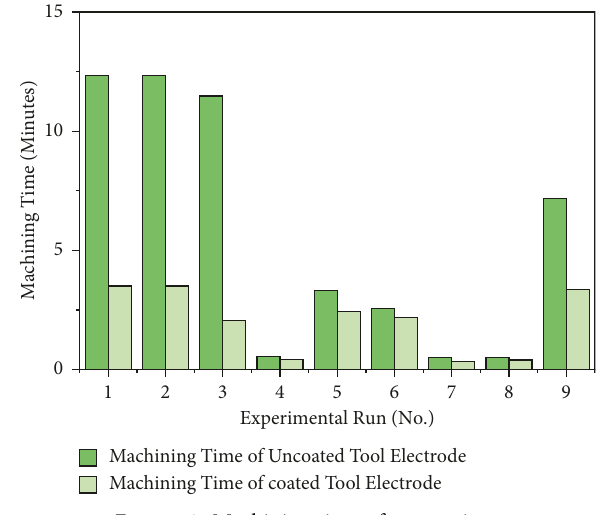
Figure 2: Machining time of